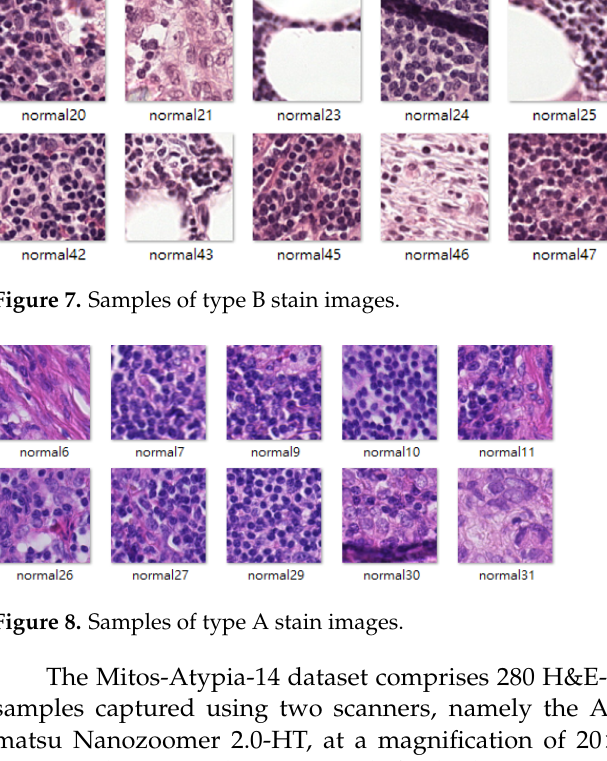
Figure 9. Example images from the Mitos-Atypia-14 dataset. 4.2. Evaluating the Tumor Classification Performance This experiment was conducted with the Camelyon16 dataset, and the tumor classi- fication performance obtained for with/without stain style transfer was employed to indi- rectly verify the effectiveness of the proposed stain transfer method. A simple classifica- tion network architecture, the same as Figure 6, was used in this experiment because of its weak generalization capability, such that an excellent classification performance can be obtained only when the input image features are similar to the trained image features. Thus, the classification performance can indicate the similarity between the style-trans- ferred images and the target images. We used the type B stain images [9] to train the tumor classifier. Next, the type A stain images [9] were converted to type B stain images via different stain transfer methods. These transferred type B stain images were input into the trained tumor classifier to evaluate the classification accuracy and indirectly verify the effectiveness of the different stain transfer methods. Figure 10 shows the stain-transferred images using different approaches. We can find that the transferred image using the proposed method has the closest overall tone to the reference image. The results presented in Table 1, annotated as “(simple classifier)”, indi- cate that the proposed method produced superior classification performance to the other methods. This result indirectly indicates that the produced images by the proposed method are the closest to the training dataset’s type B stain image features. In Table 1, S3CGAN* refers to the S3CGAN without a specialized color classifier. The AUC value of the S3CGAN was 2% higher than that of the S3CGAN*, which proves that the specialized